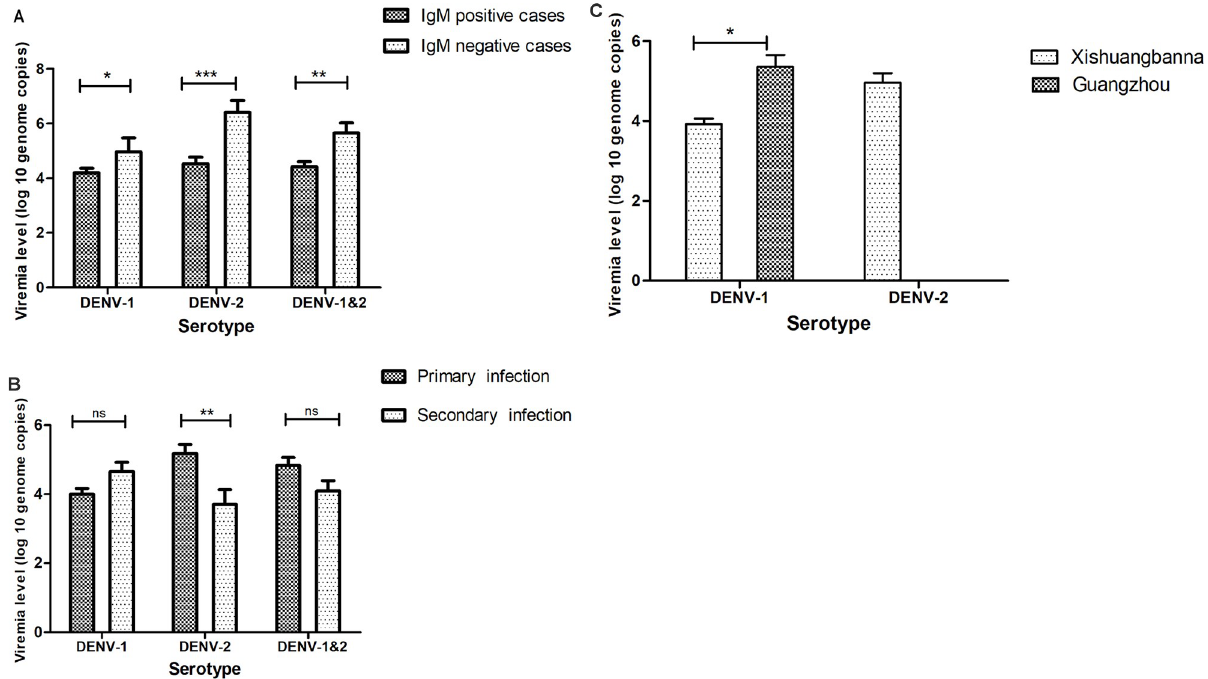
Fig 4. Comparison of viremia levels of dengue patients as estimated by RT-qPCR. (A) in DENV IgM positive vs DENV IgM negative patients. (B) and in primary vs secondary DENV infections. (C) in Guangzhou and Xishuangbanna